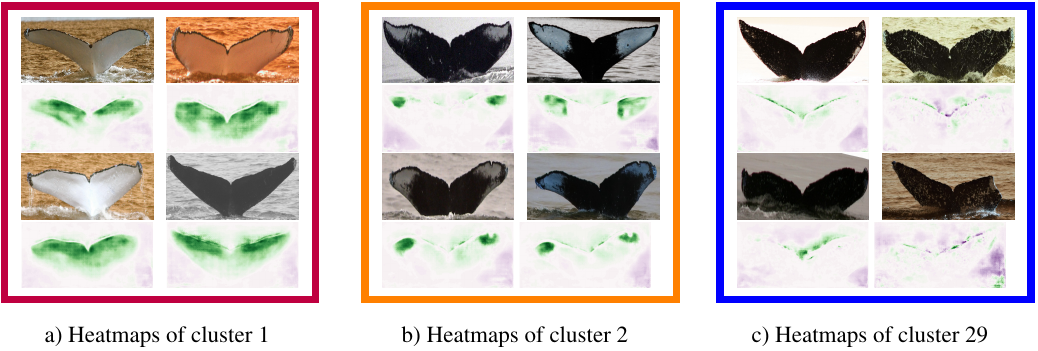
Figure 7. Spectral Clustering analysis is applied to the OSM heatmaps to identify different prediction characteristics within the analyzed data. Three exemplary prediction characteristics are shown. a) Detect total fluke as positive sensitive. b) Detect pigmentations near the fluke tips as positive sensitive. c) Nothing specific is detected positive sensitive. No distinctive features are